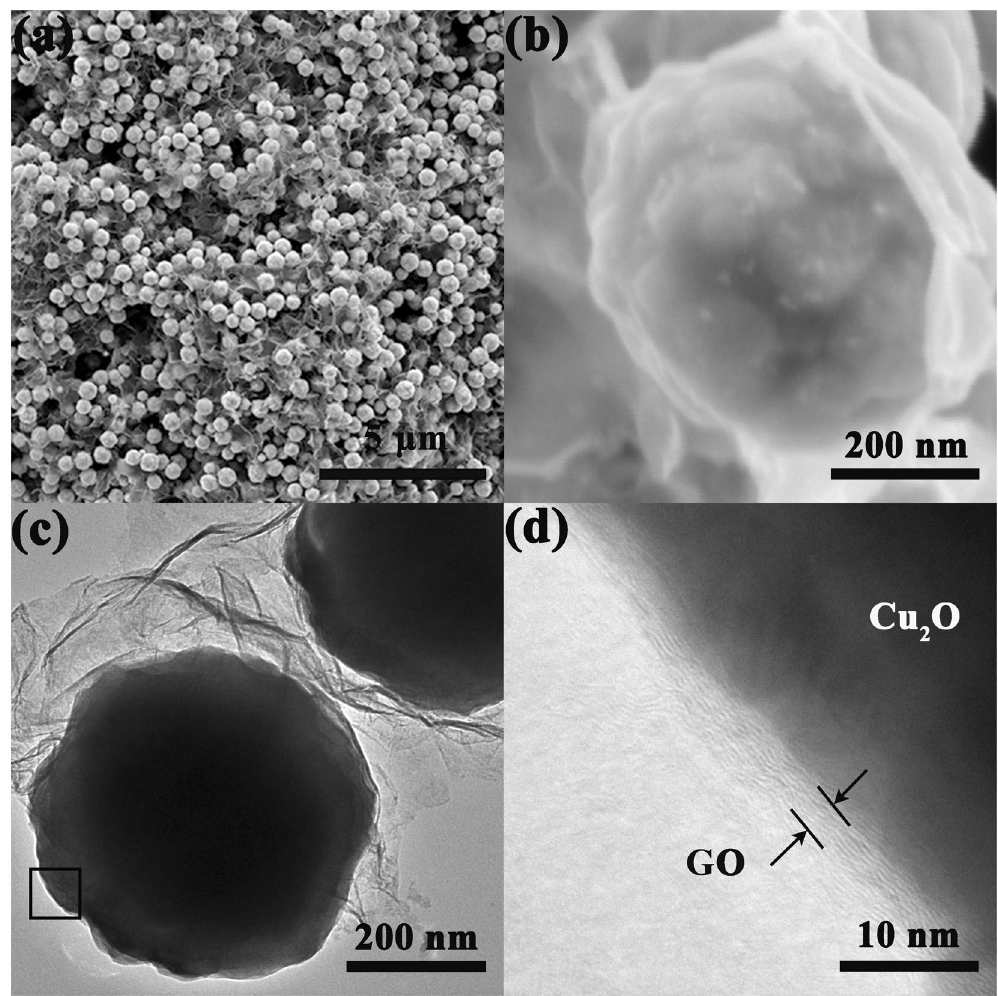
Figure 2. ( a , b ) SEM, ( c ) TEM and ( d ) HRTEM images of the Cu 2 O nanosphere/GO